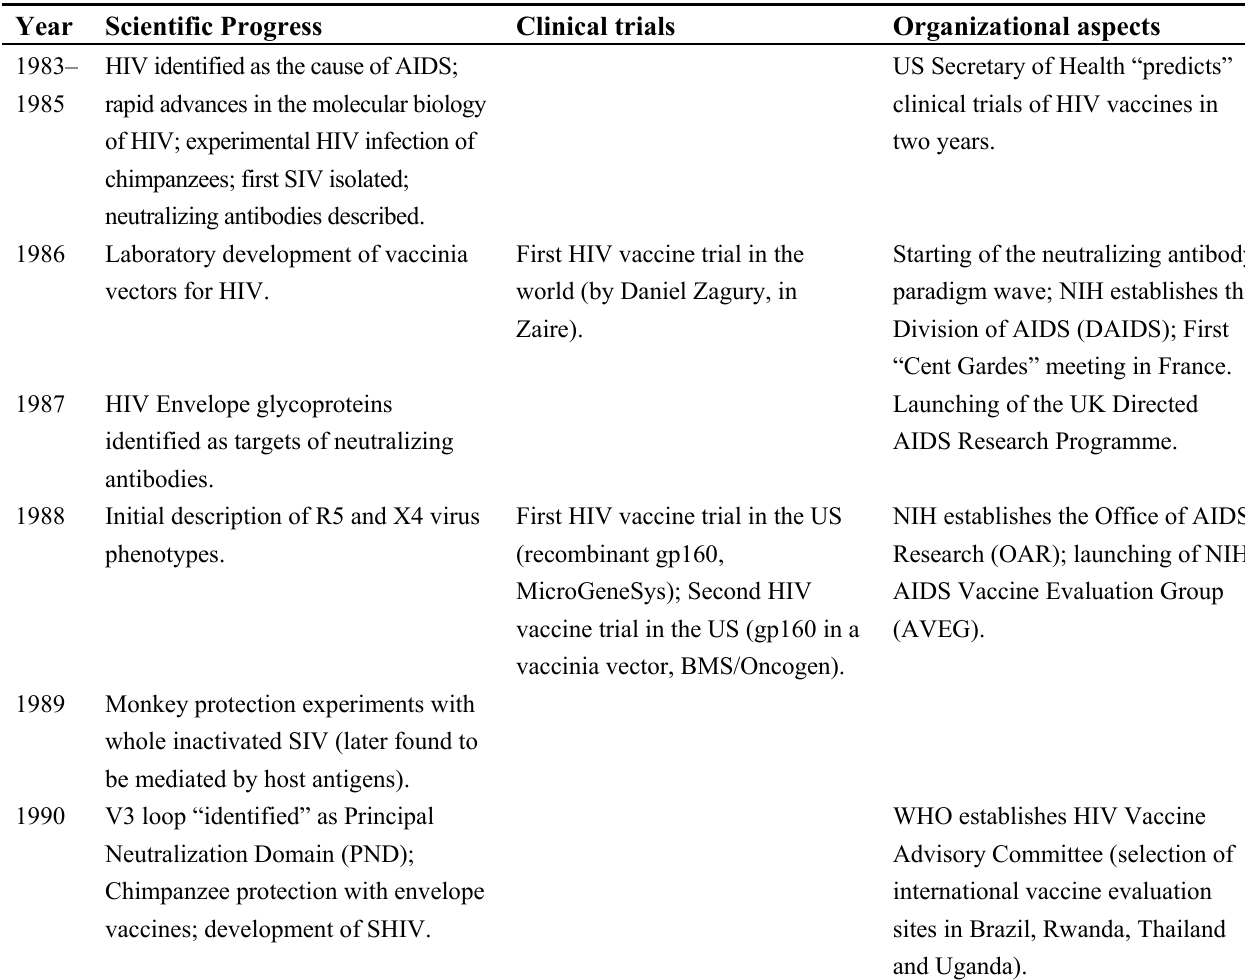
Table 1. Key events on the history of HIV vaccine research and